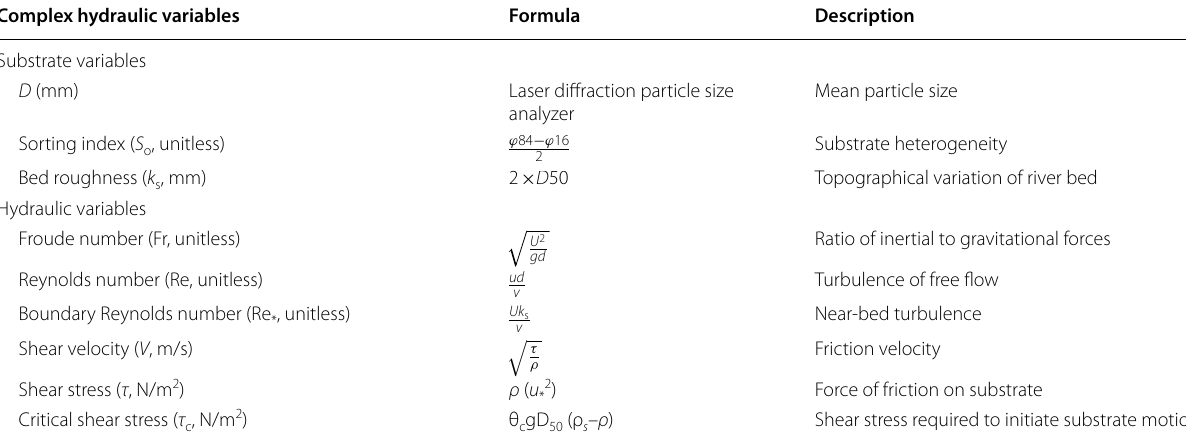
Table 3 Calculation of complex hydraulic variables for four habitats in Poyang